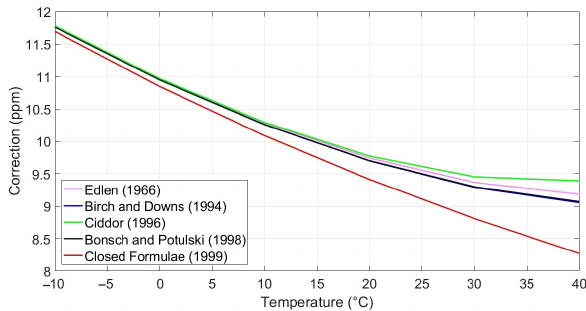
Figure 7. EDM corrections in every interval of 10 °C